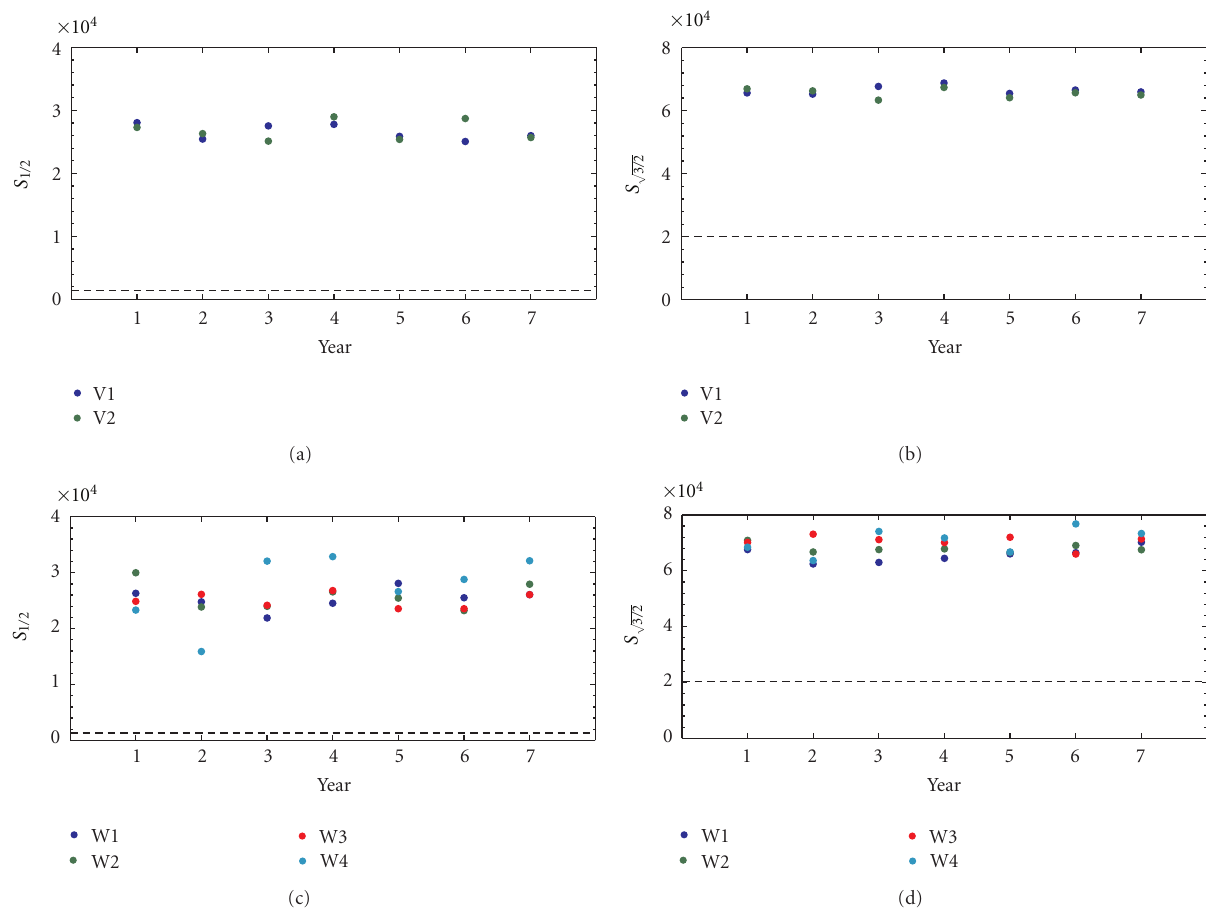
Figure 20: The S statistics of the simulated data produced by the WMAP team. Dashed lines show the values of WMAP data.